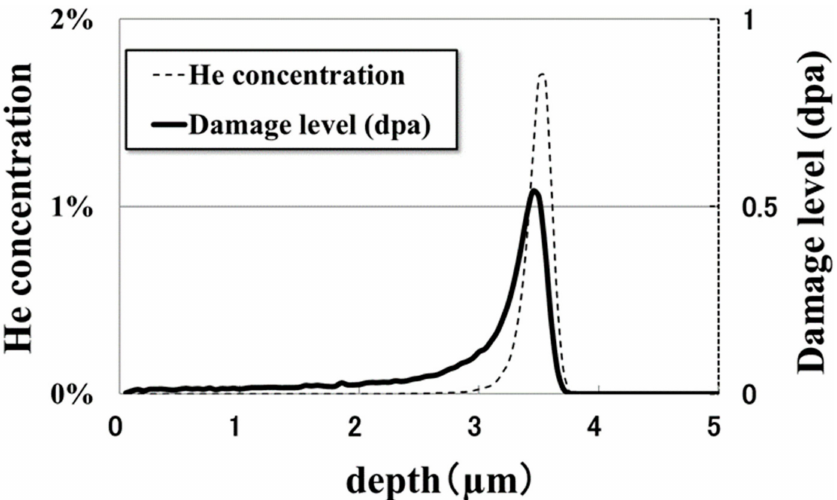
Figure 1. Calculation results of ion range profile of implanted He ion and vacancy concentration profile in V by 2-MeV He + ion